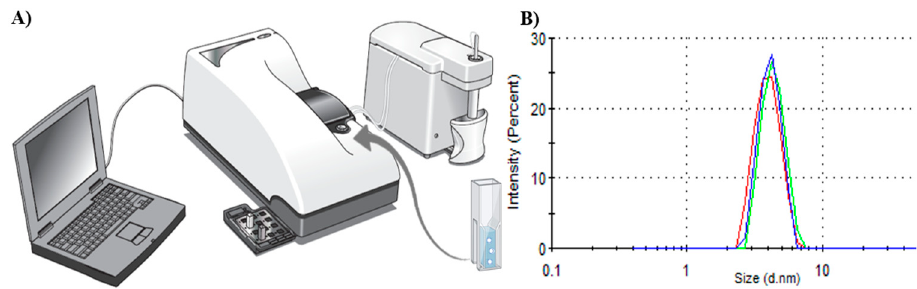
Figure 6. General diagram of particle size characterization of reverse micelles in AOT/Isooctane/ Water systems. ( A ) Working platform arrangement with ZetaSizer nano ZS90, ( B ) Visualization of the size distribution of a random sample.